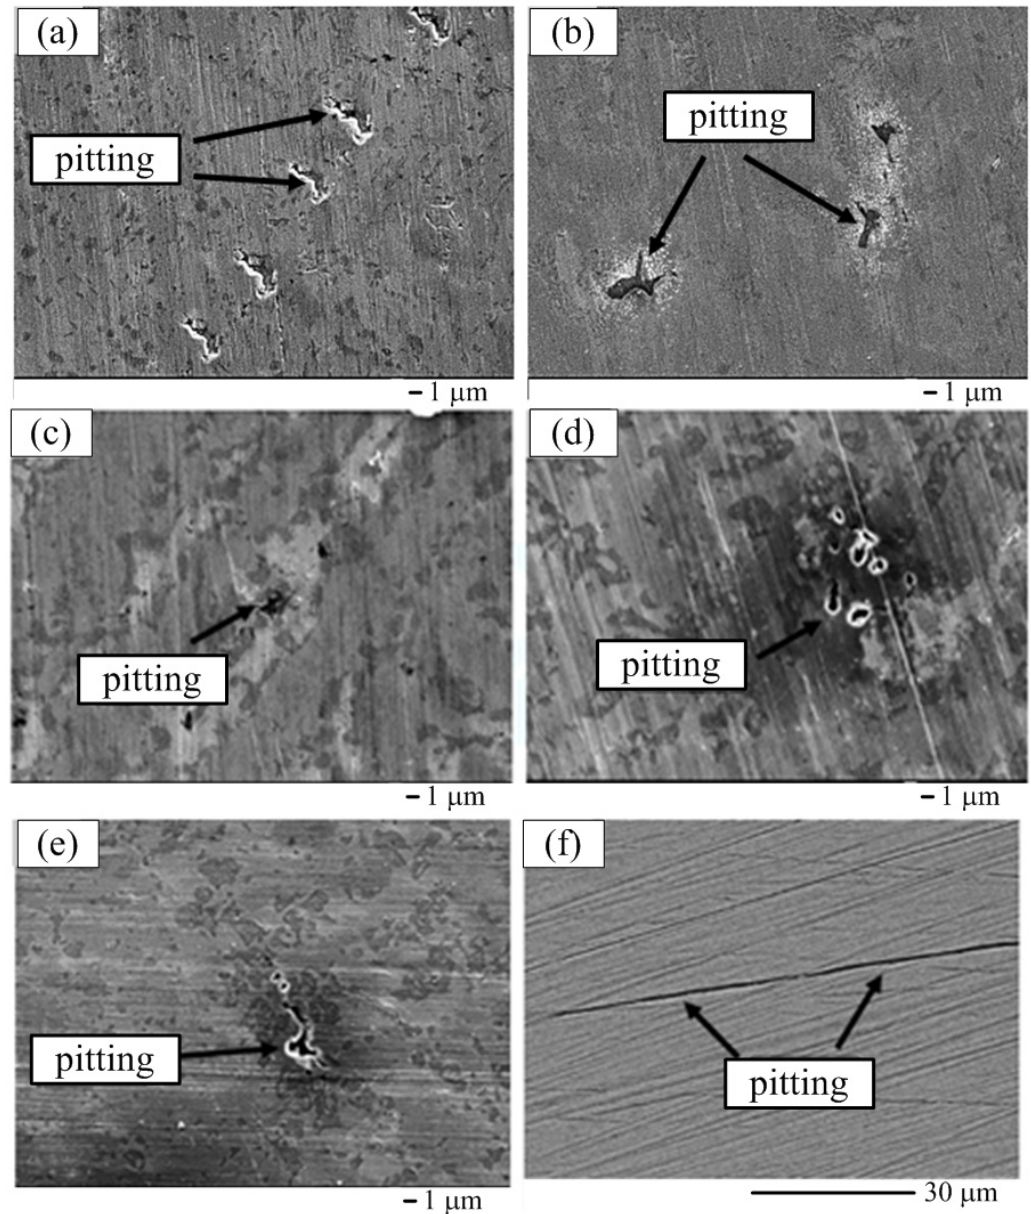
Figure 11. SEI surface morphologies of the CuFeTiZrNi x alloys after the polarization test in 3.5 wt.% NaCl solution for 30 days: ( a ) x = 0.1, ( b ) x = 0.3, ( c ) x = 0.5, ( d ) x = 0.8, and ( e ) x = 1.0, and ( f ) SUS 304.